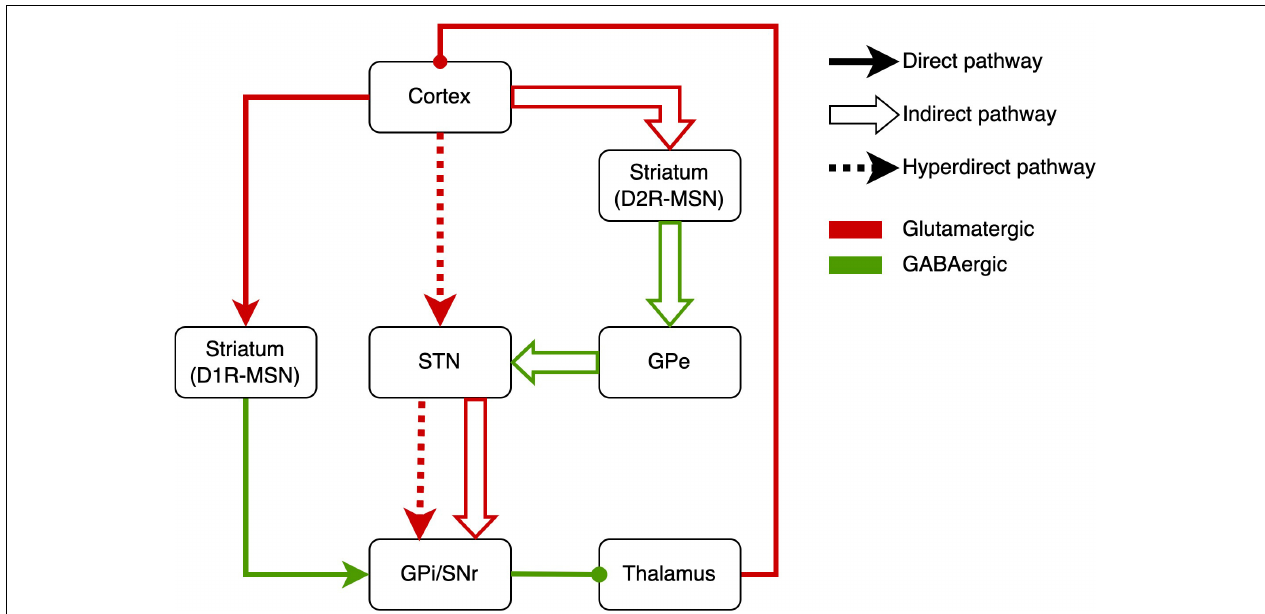
FIGURE 1 | Schematic drawings of the direct pathway, indirect pathway, and hyperdirect pathway. GPe, external segment of the globus pallidus; GPi, internal segment of the globus pallidus; SNr, substantia nigra pars reticulata; STN, subthalamic nucleus; MSN, medium spiny